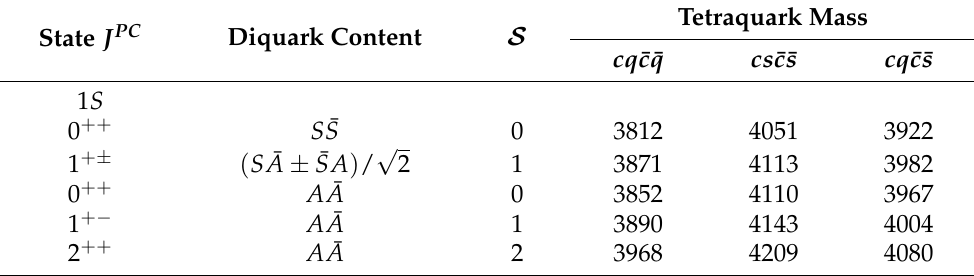
Table 4. Masses of hidden charm diquark–antidiquark states (in MeV). S and A denote scalar and axial vector diquarks; S is the total spin of the diquark and antidiquark. ( C is defined only for q = q (cid:48)